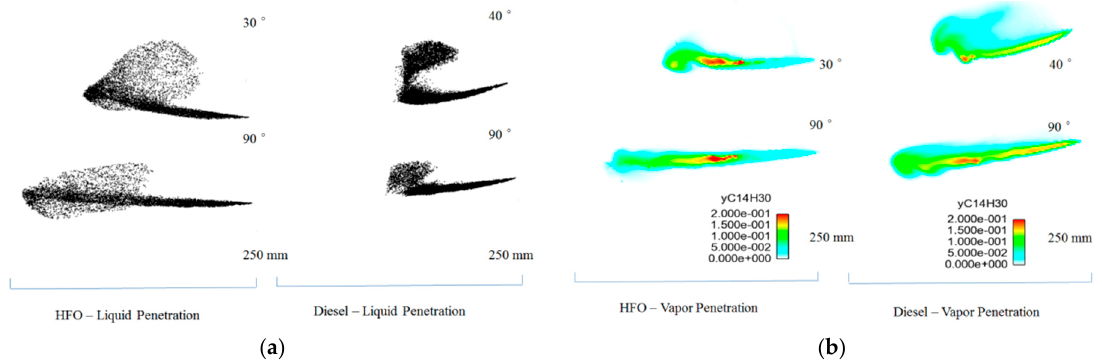
( f ) Figure 3. Comparison of liquid and vapor spray penetrations obtained by simulation and experiment for HFO and diesel under different ambient pressures. ( a ) Liquid phase penetration at 3 MPa of ambient pressure; ( b ) Vapor phase penetration at 3 MPa of ambient pressure; ( c ) Liquid phase penetration at 6 MPa of ambient pressure; ( d ) Vapor phase penetration at 6 MPa of ambient pressure; ( e ) Liquid phase penetration at 9 MPa of ambient pressure; ( f ) Vapor phase penetration at 9 MPa of ambient pressure. 4.1.2. Spray Characteristics at Different Swirl Ratios